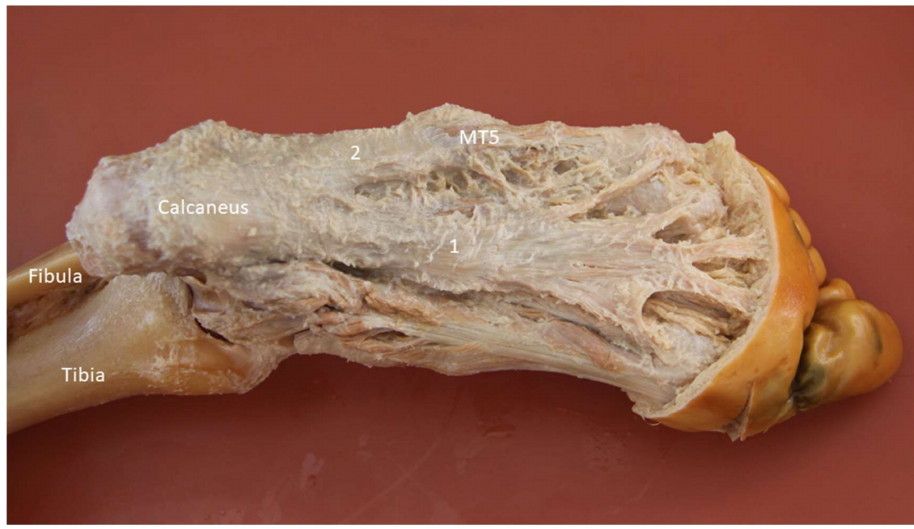
Figure 14. Cadaveric model of the lateral cord of plantar fascia (2). 1: Medial cord of plantar fascia; MT5: fifth metatarsal base.